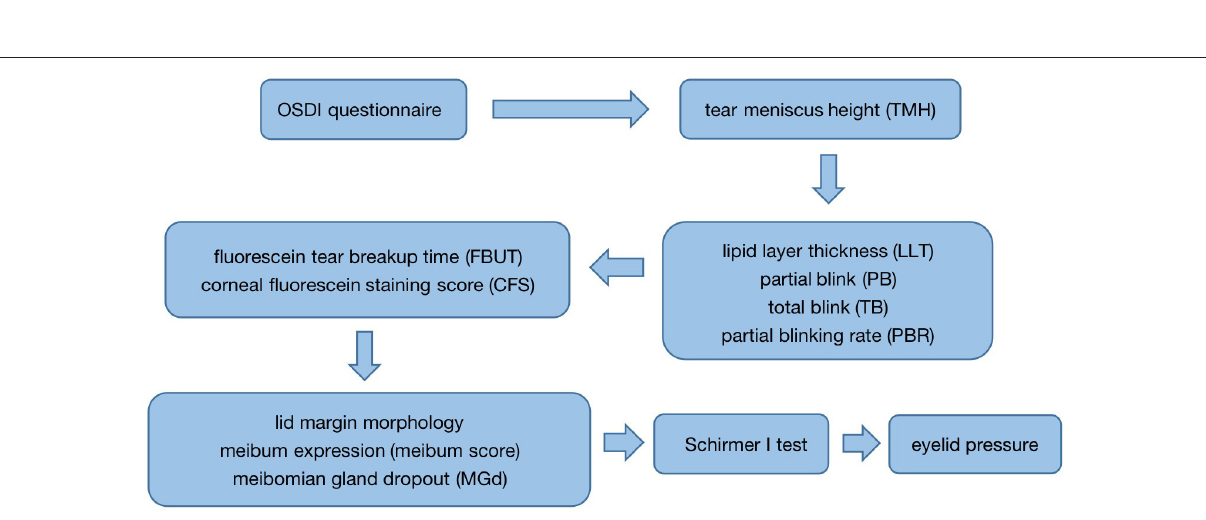
FIGURE 3 | The process of all